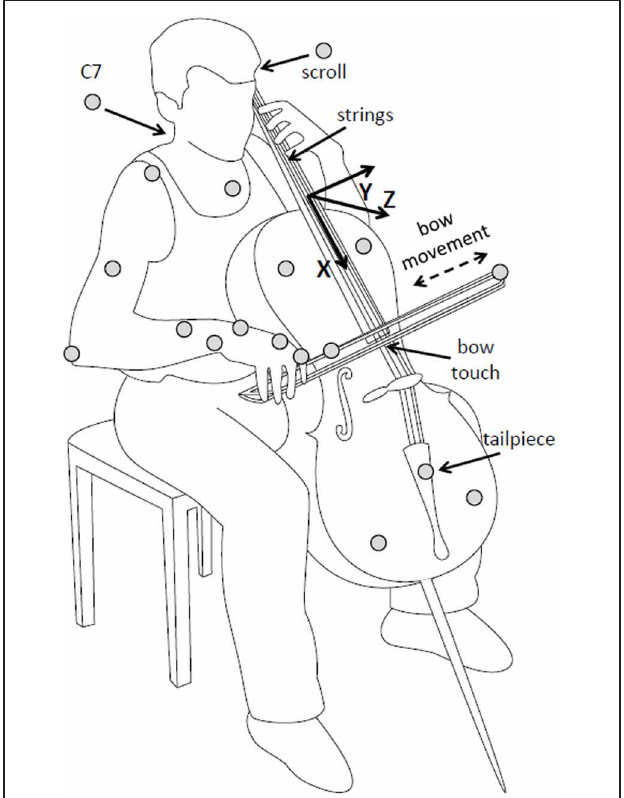
FIGURE 1 | Illustration of setup, instrument, and task. Marker positions are indicated as gray circles. The cello-centered coordinate system is indicated (note that the actual origin was defined to be at the scroll marker). Reproduced with permission from Verrel et al.